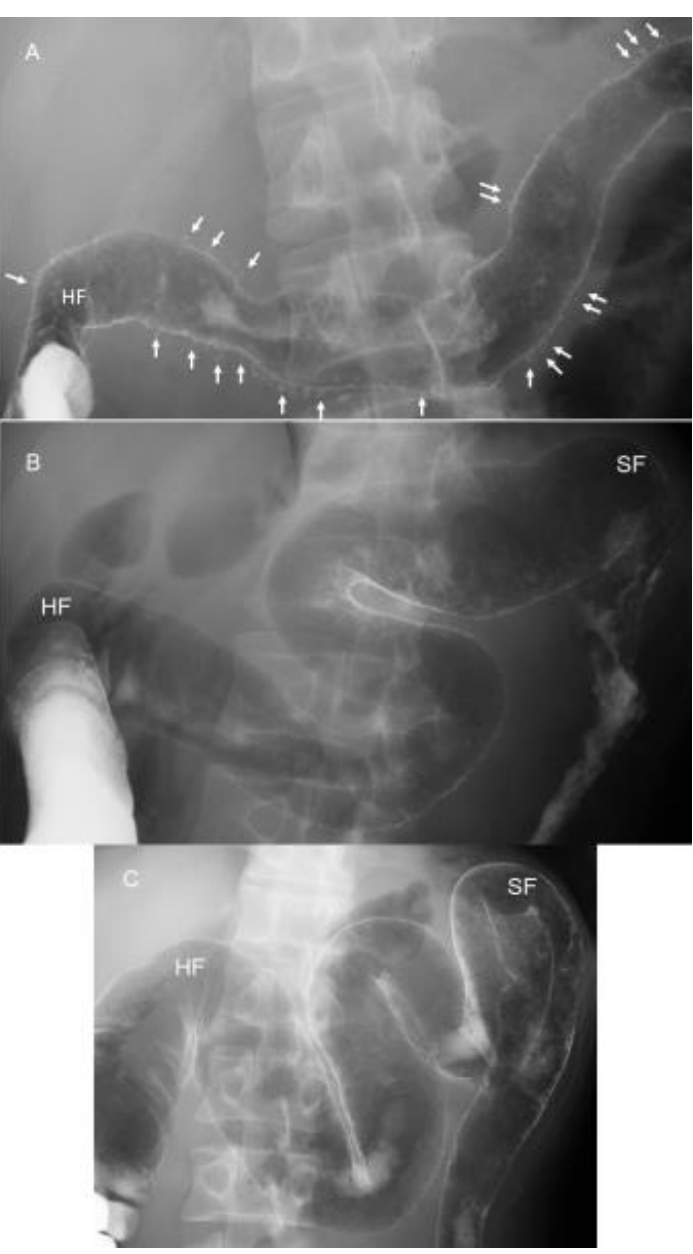
Figure 12. Roentgenograms of barium enema study during the induction phase in a 34-year-old man with severe ulcerative colitis (initial episode case) treated with infliximab and a plant-based diet as first-line (IPF) therapy. Numerous collar button ulcerations (arrows) are observed in the whole transverse colon 1 day before IPF therapy ( A ). They are resolved on the 13th day, 1 day before the second infliximab infusion ( B ). Further recovery with good distensibility is observed 1 day before the third infliximab infusion ( C ). HF, hepatic flexure; SF, splenic flexure.